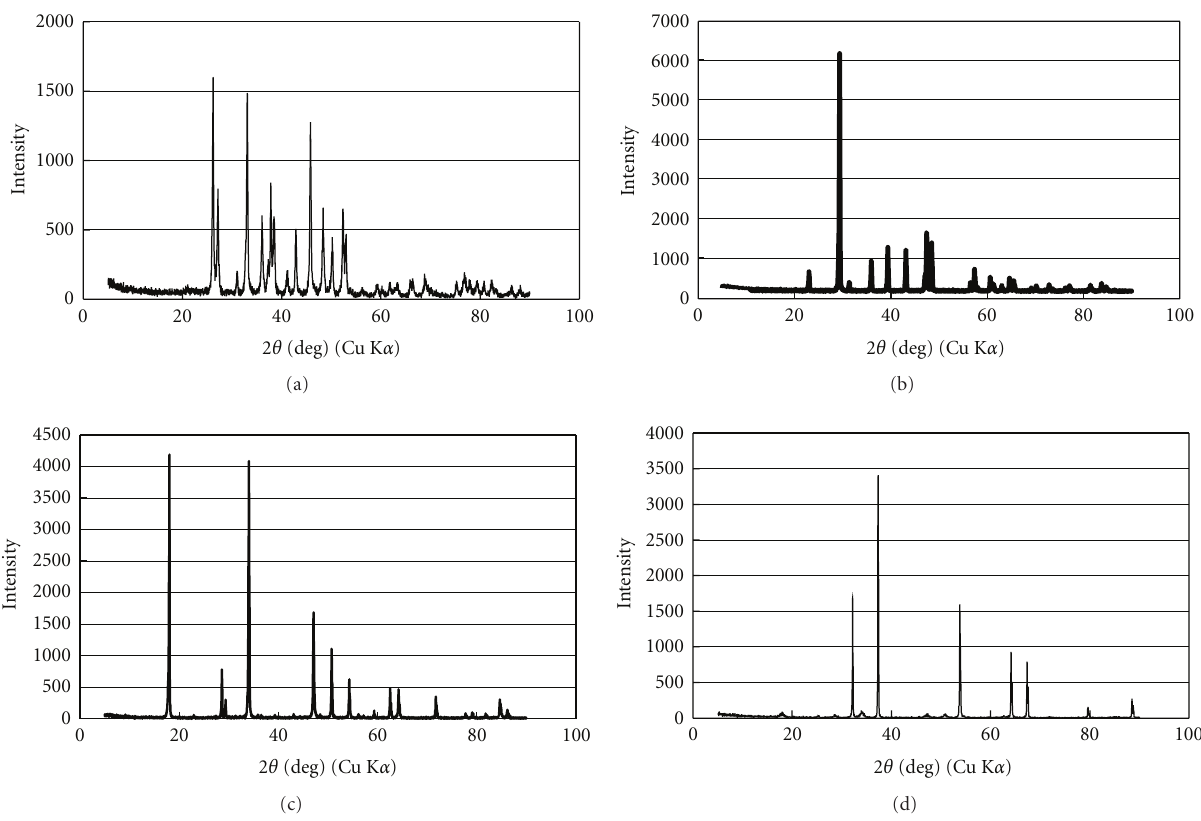
Figure 1: X-ray di ff raction (XRD) patterns of Buccinum tenussimum shell biomass before adsorption of metals. (a) ground original sample, (b) heat-treatment (480 ◦ C) sample, (c) heat-treatment (950 ◦ C) sample, and (d) heat-treatment (950 ◦ C) and water-added sample.